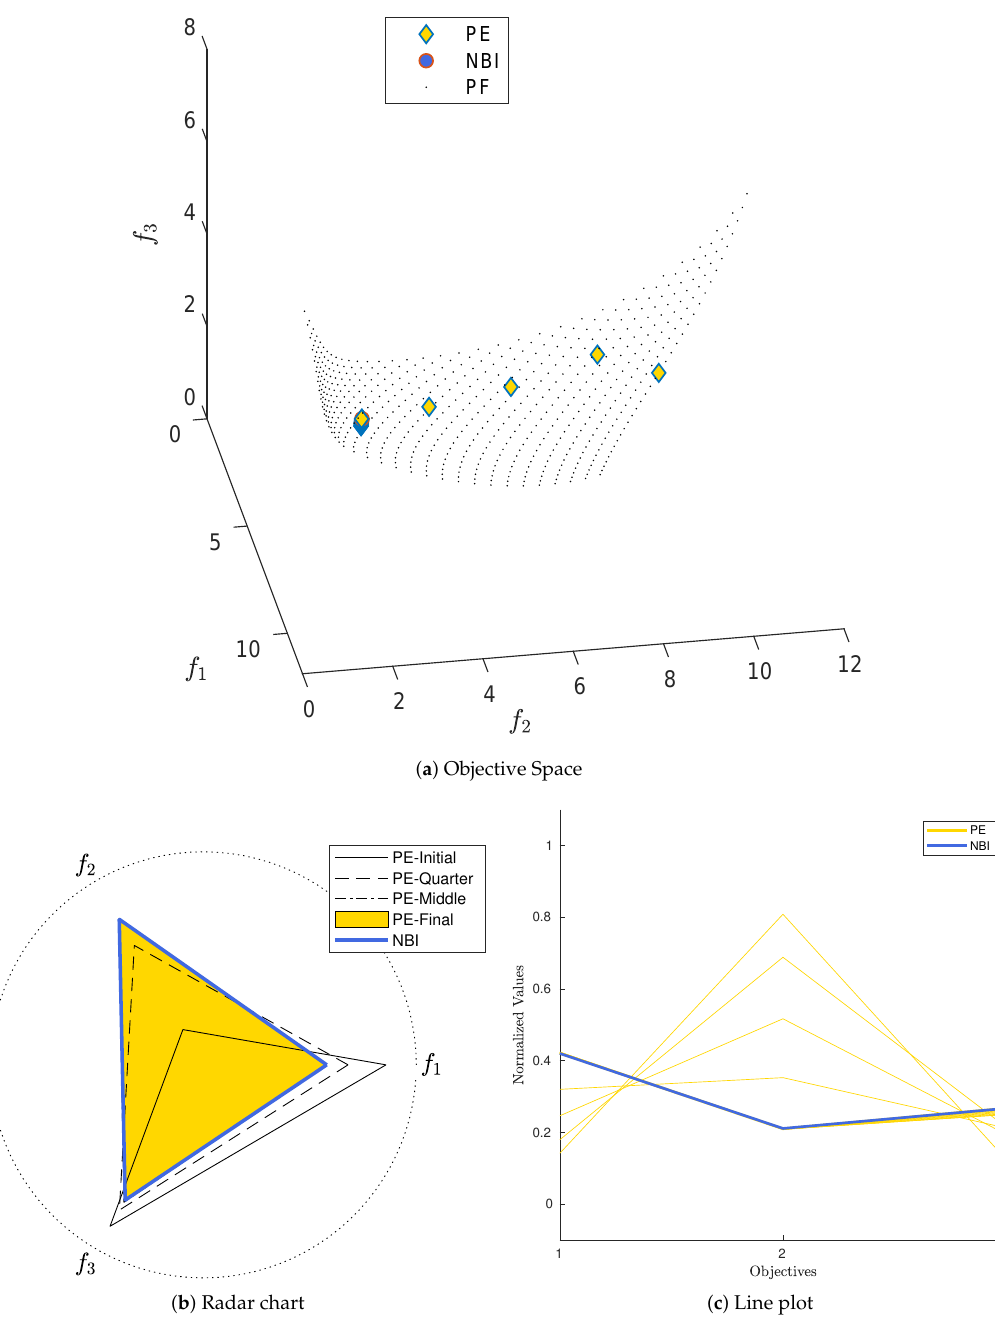
Figure 7. Numerical results for MOP